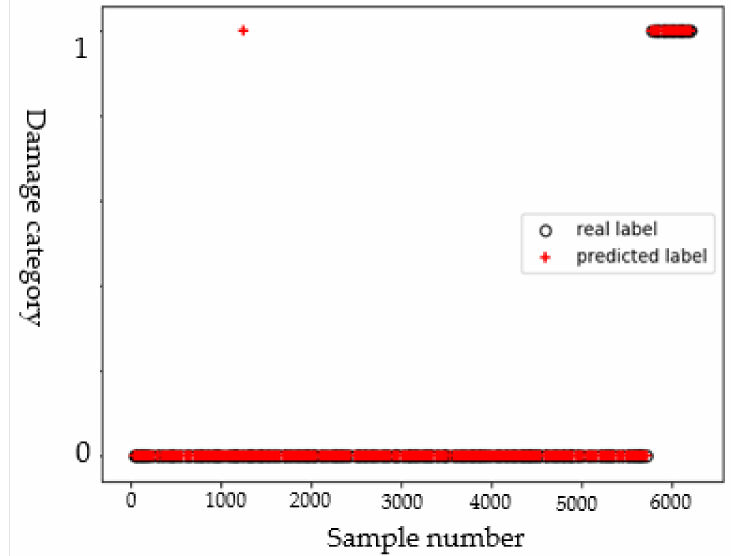
Figure 5. Scatter diagram of identification results of the defect